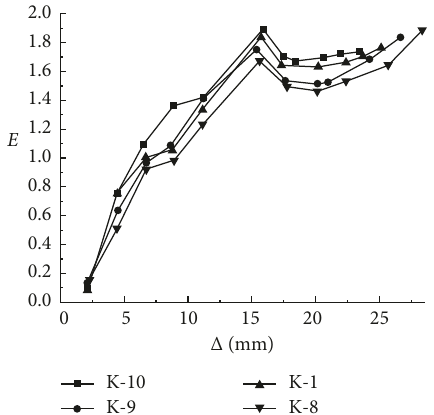
Figure 18: Curves of coefficients of energy dissipation for various axial compression